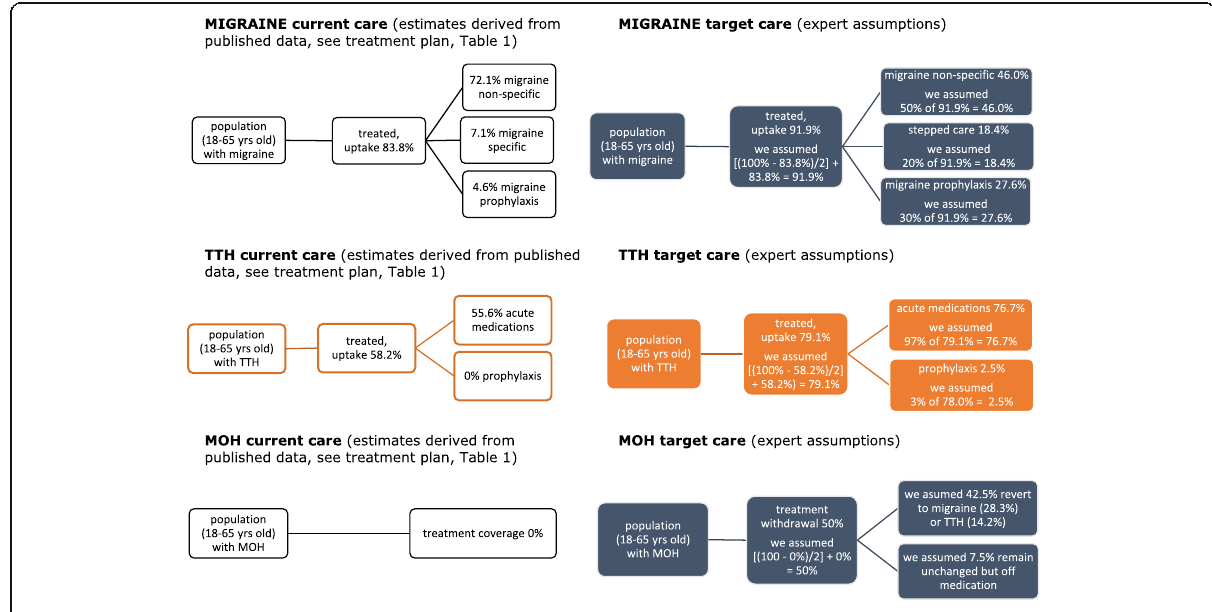
Fig. 2 Analytical models for Luxembourg (data are reported in Table 1)